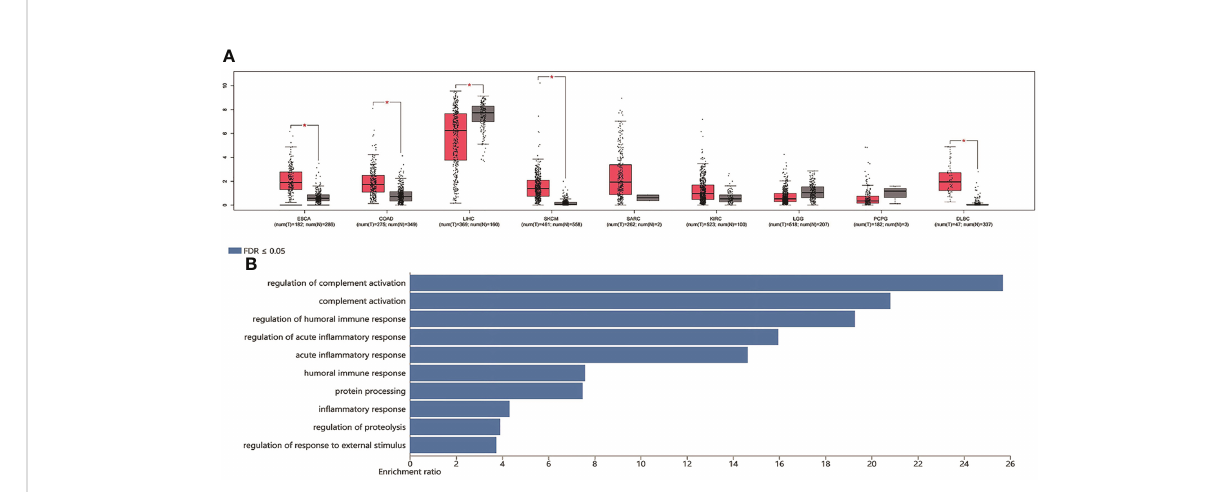
FIGURE 5 TDO2 expression in TCGA data set and biological function analysis. (A) The expression of TDO2 in malignant tumors and adjacent tissues (B) KEGG enrichment analysis of TDO2 related genes. TDO2, tryptophan 2,3-Dioxygenase; HR, hazard ratio; KEGG, Kyoto Encyclopedia of Genes and Genomes; FDR, false discovery rate; ESCA, esophageal carcinoma; COAD, colon adenocarcinoma; LIHC, liver hepatocellular carcinoma; SKCM, skin cutaneous melanoma; SARC, sarcoma; KIRC, kidney renal clear cell carcinoma; LGG, brain lower grade glioma; PCPG, pheochromocytoma and paraganglioma; DLBC, lymphoid neoplasm diffuse large B-cell lymphoma.*p-value < 0.05.